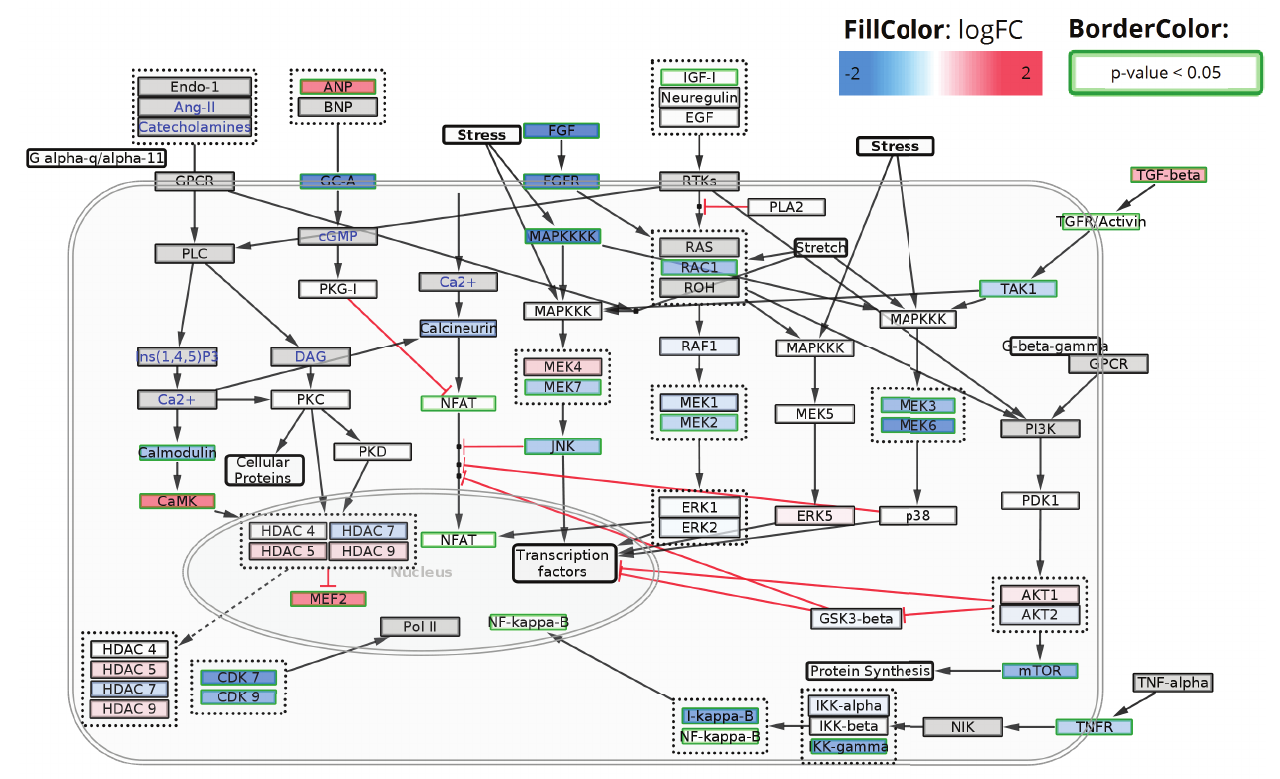
Figure 1. The Cardiac Hypertrophic Response pathway loaded as a pathway. LogFC values are visualized as node fill color with a color gradient from blue over white to red. Significant measurements (adjusted p-value < 0.05) are highlighted with a green border color. Elements in the pathway without a measurement are colored